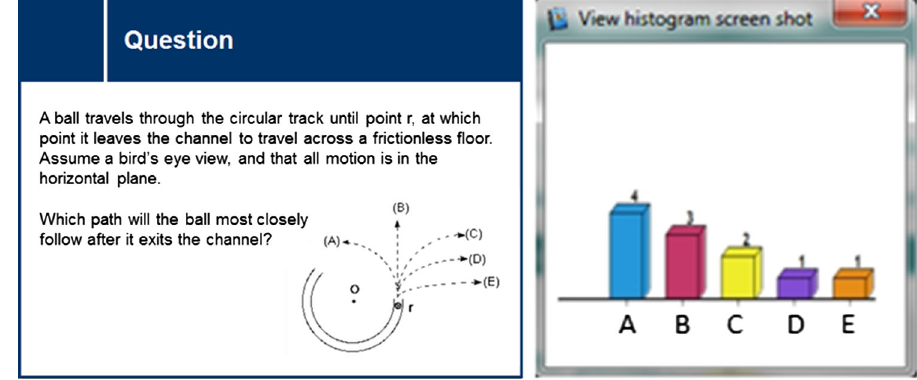
FIG. 1. An example of a conceptual mechanics multiple-choice question from Force Concept Inventory and the distribution of TCs ’ responses